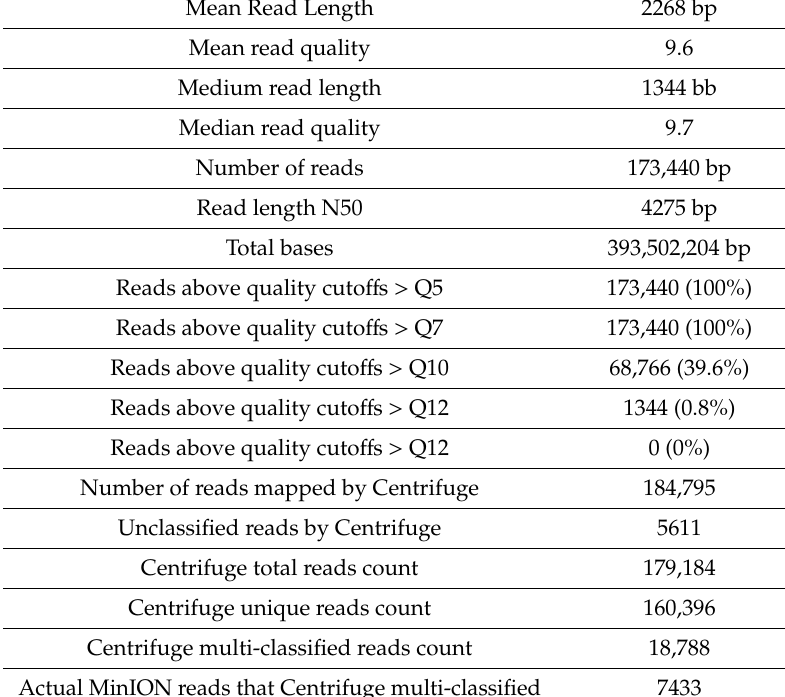
Table 1. Nanoplot statistics for the MinIT base-calling output and post MinION Detection Software (MINDS) statistics for the Centrifuge analysis. The average multi-classified read mapped to 2.53 species (Centrifuge multi-classified reads count / Actual MinION reads that Centrifuge